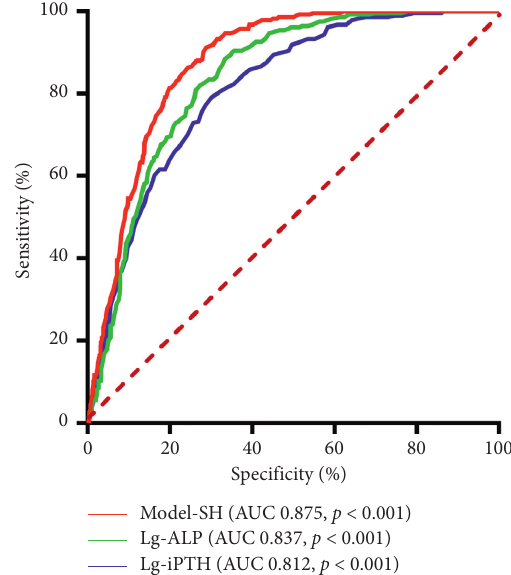
Figure 2: ROC curves for postoperative severe hypocalcemia by the binary logistic regression equation. This graph shows the ROC curves for preoperative Lg-iPTH (blue), Lg-ALP (green), and Model-SH (red). The prognostic factors in Model-SH include preoperative serum calcium, iPTH, and ALP. AUC for Lg-iPTH and Lg-ALP were 0.812 and 0.837, respectively. The cut-off values for Lg-iPTH and Lg-ALP were 3.21 and 2.32, respectively. AUC for Model-SH was 0.875 and the cut-off value was 3.25. The sensitivity and specificity of Lg-iPTH were 78.9% and 70.7%, respectively. The sensitivity and specificity of Lg-ALP were 90.5% and 64.7%, re- spectively. The sensitivity and specificity of Model-SH were 90.8% and 71.9%, respectively. Predictor � 0.738 ∗ Lg-ALP+ 1.205 ∗ Lg- iPTH − (albumin − adjusted calcium) (all of the indexes were